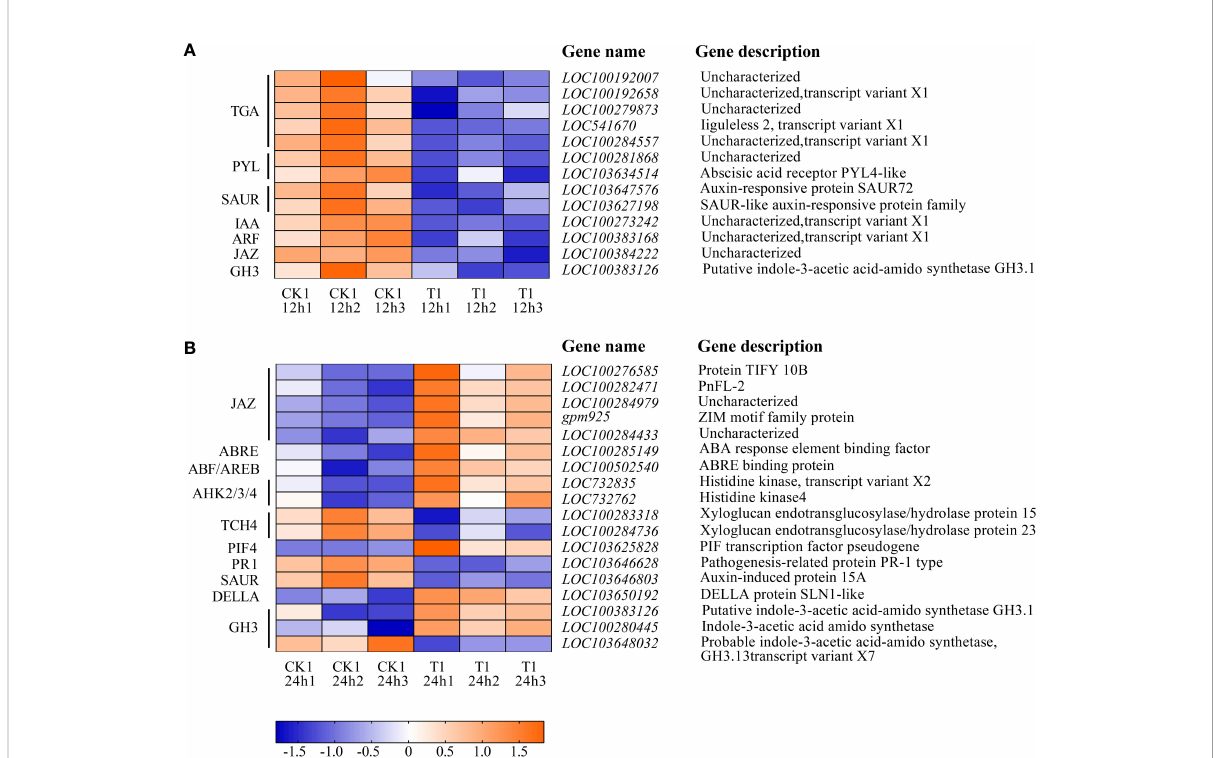
FIGURE 8 Heatmap of the DEGs involved in plant hormone signal transduction between CK1 and T1. (A) Treatment for 12 h. (B) Treatment for 24 h. The color in the fi gure indicates the expression magnitude of the gene after normalization treatment in each sample. Orange means upregulated expression of genes, and blue means downregulated expression of genes. The number in each sample name represents the sample